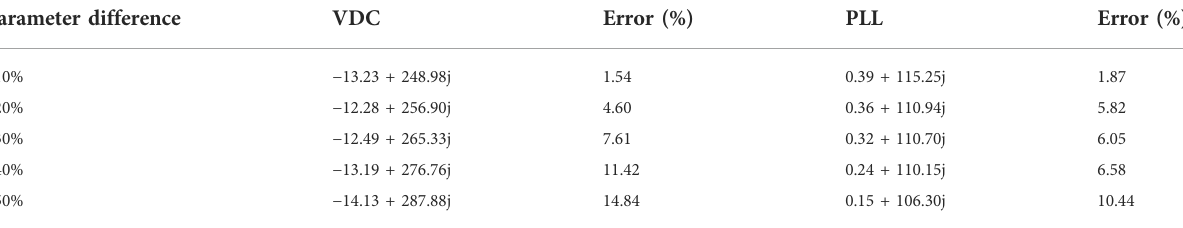
TABLE 5 Oscillation modes of the cluster of twenty-three inverters in daisy-chain connection with different parameter settings. Parameter difference